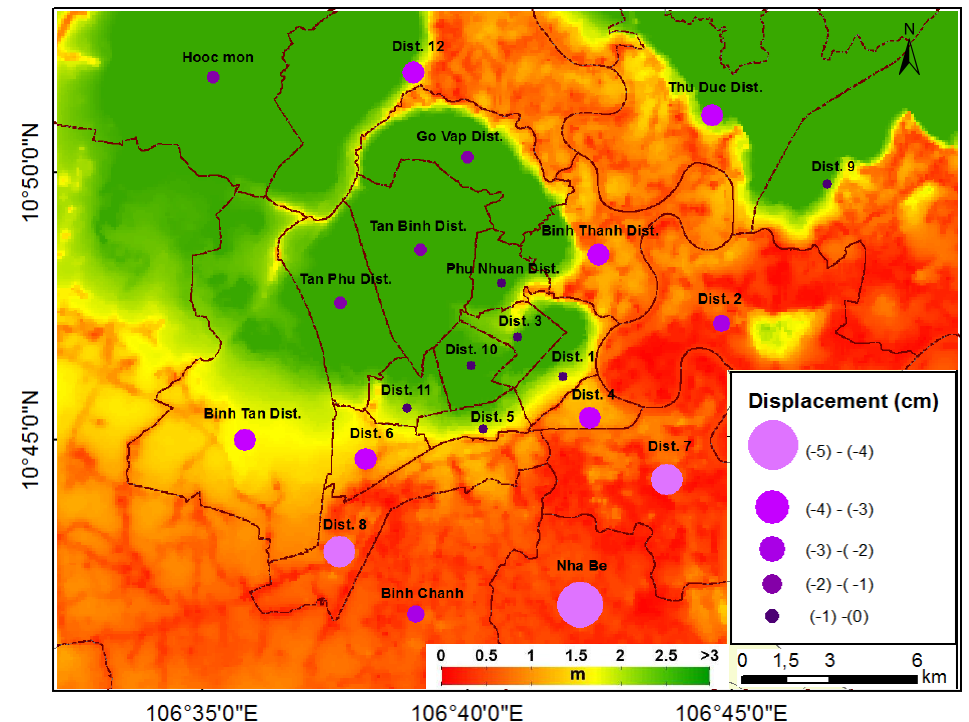
Figure 9. The topographic elevation map in 2010 and the average displacement value for each district for the period of 2006 to 2010.